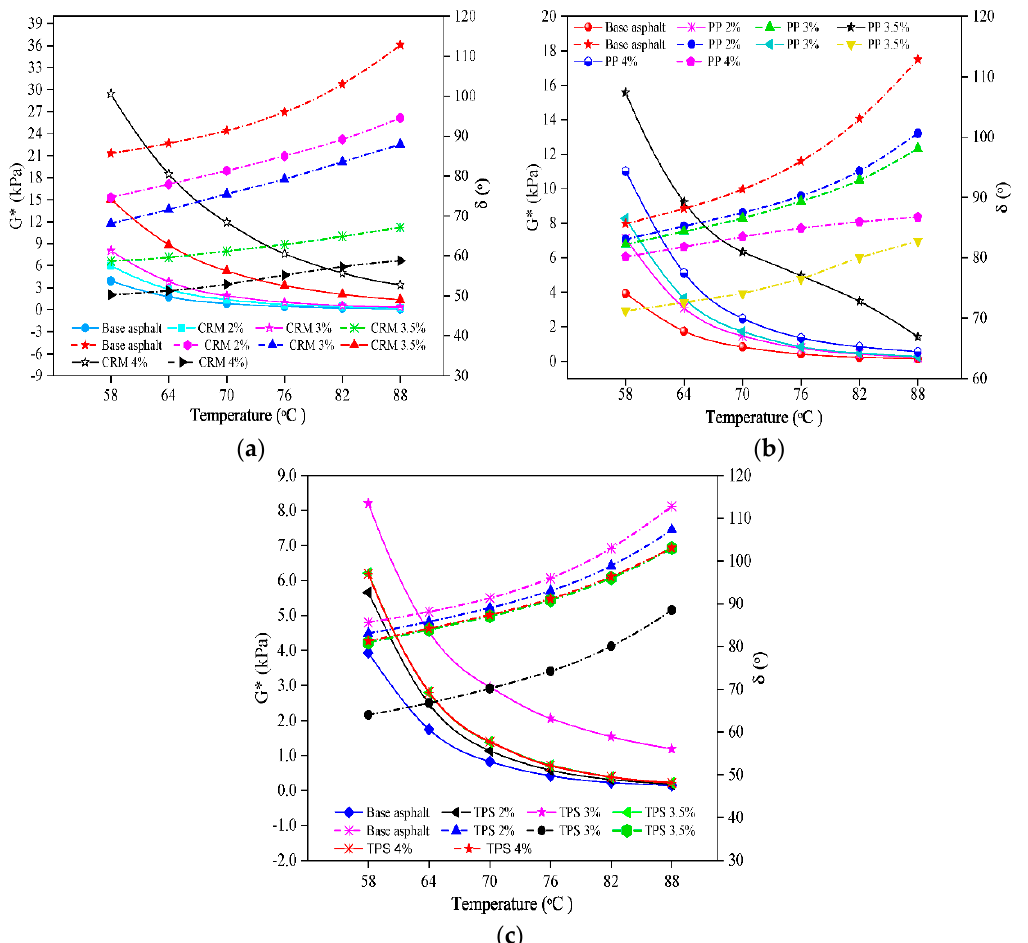
Figure 9. G* (left) and δ (right) serving as a function of temperature for modified binders: ( a ) CRM; ( b ) PP; and ( c ) TPS.